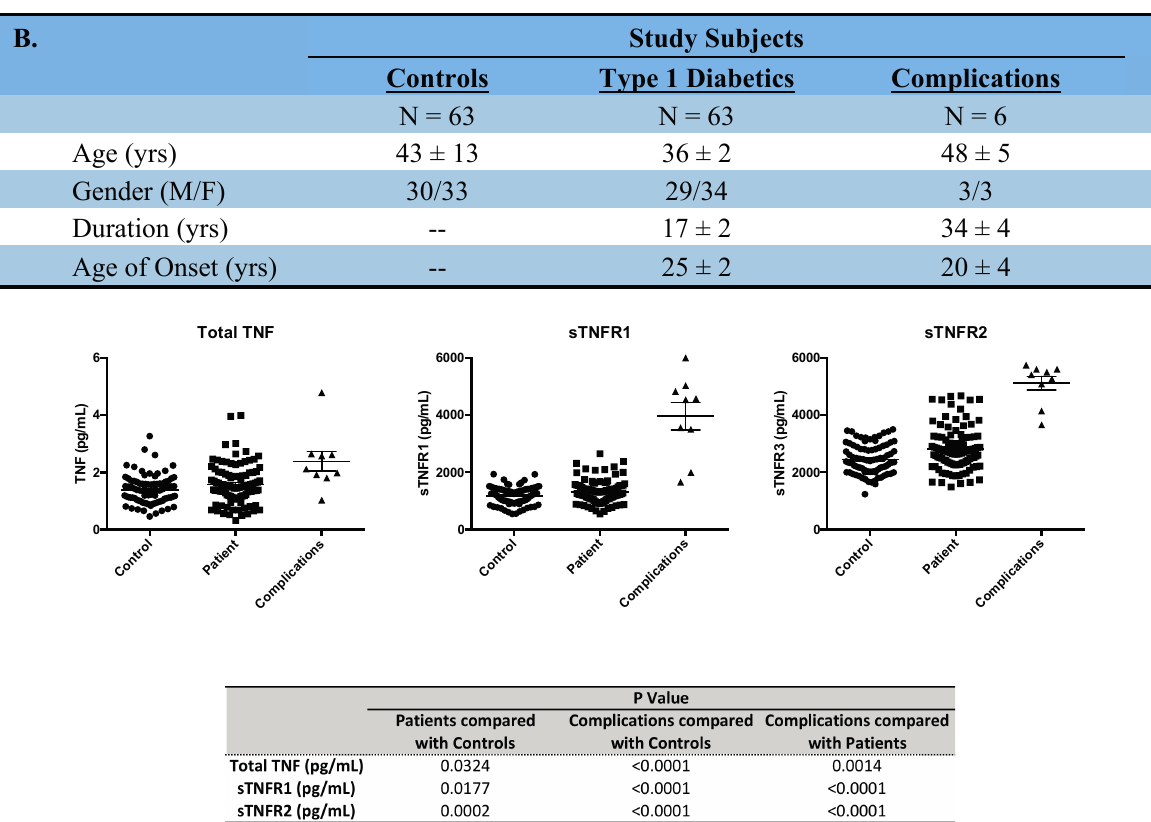
Figure 4. Serum levels of TNF, sTNFR1 and sTNFR2 were measured in the serum of control subjects (n = 63), subjects with type 1 diabetes but without renal disease (n = 63) and type 1 diabetics with renal insufficiencies (n =